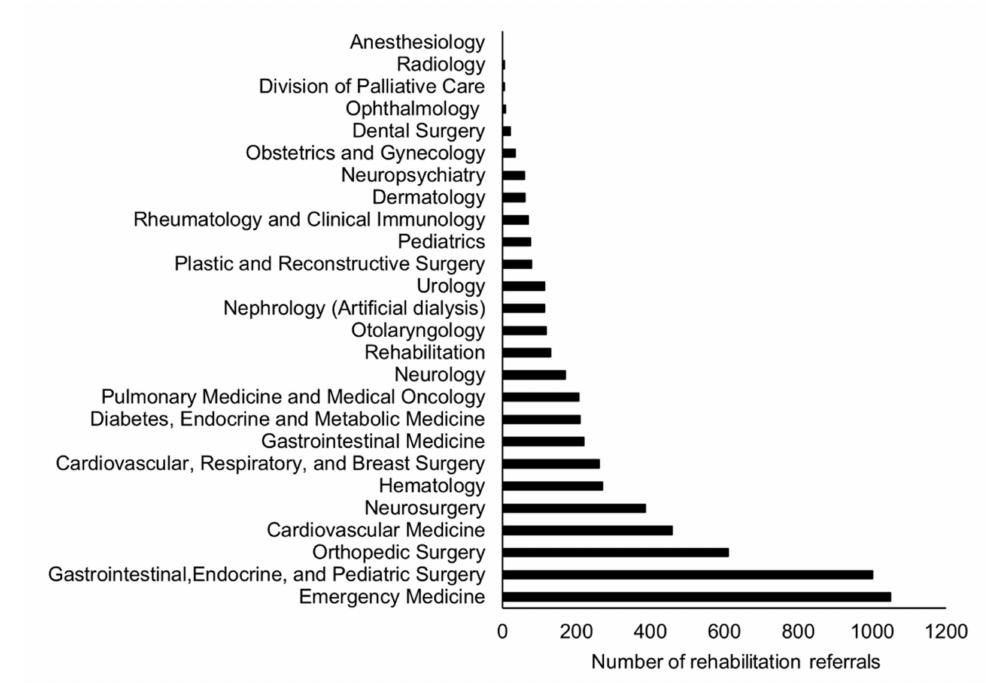
Figure 1. Annual number of patients referred to rehabilitation from each clinical